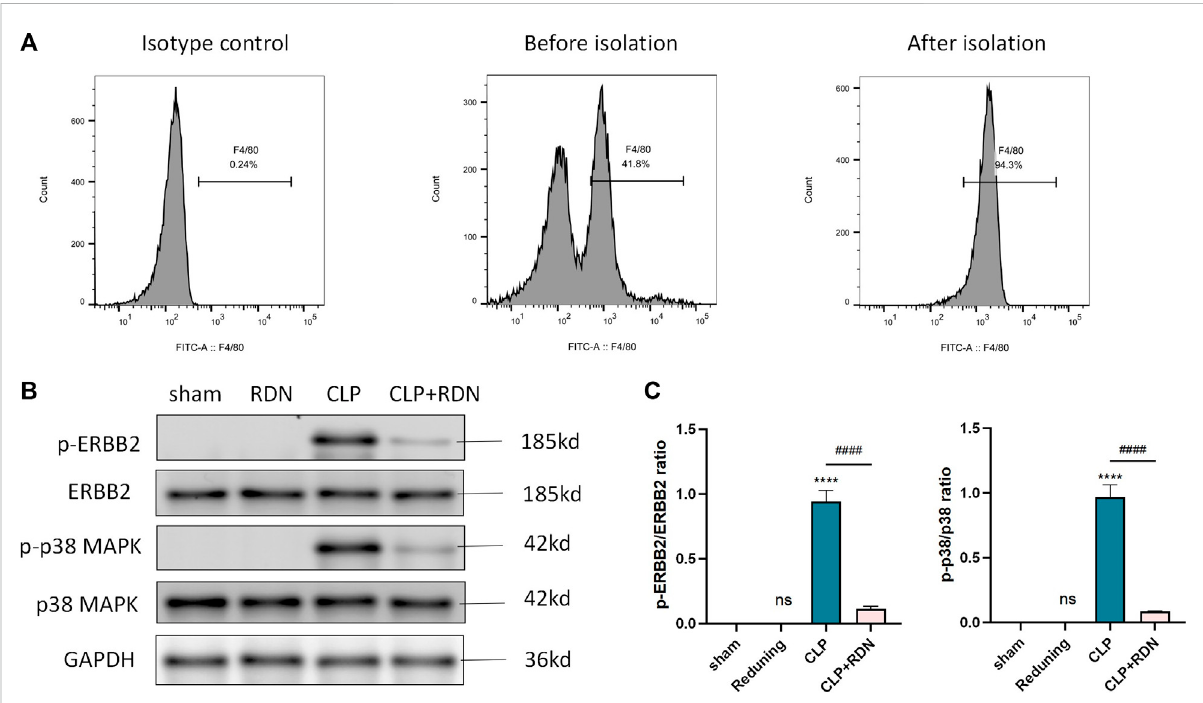
FIGURE 8 Expression of the ERBB2-p38 MAPK pathway in AMs. (A) Flow cytometry was used to isolate AMs. (B – D) The expression levels of the ERBB2- p38 MAPK pathway-related proteins were detected by Western blot. Data are presented as mean ± SD ( n = 3 per group) of the representative data from three independent experiments; **** p < 0.001 and #### p < 0.001. The asterisk (*) represents statistically signi fi cant difference between the indicated group and the Con